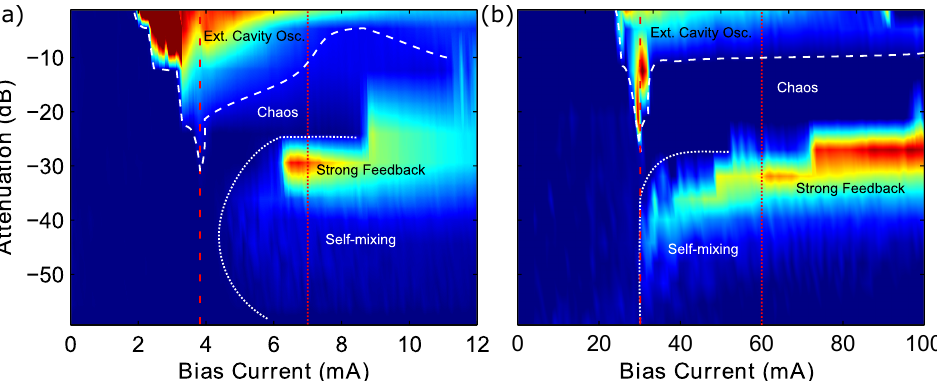
Figure 3. Bias current vs. attenuation vs. amplitude (peak-to-peak of SM displacement signal). (dashed line = Ith, dotted line = bias current, where representative waveforms and spectra were measured). ( a ) 850 nm VCSEL; ( b ) 852 nm